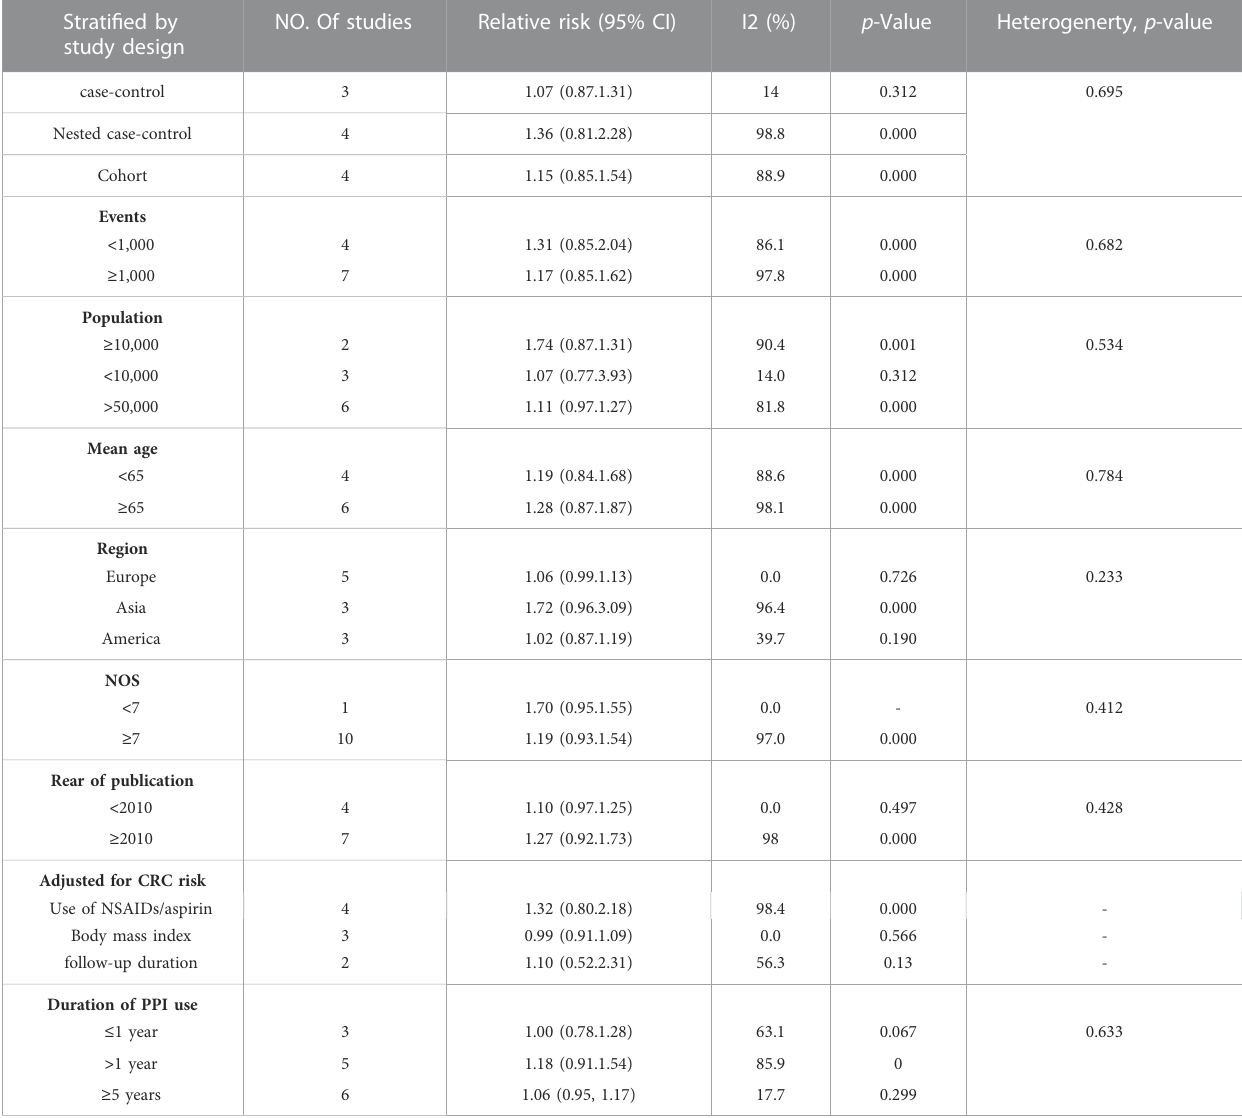
TABLE 4 Subgroup analysis of Proton Pump Inhibitor use and the Risk of Colorectal Cancer. Strati fi ed